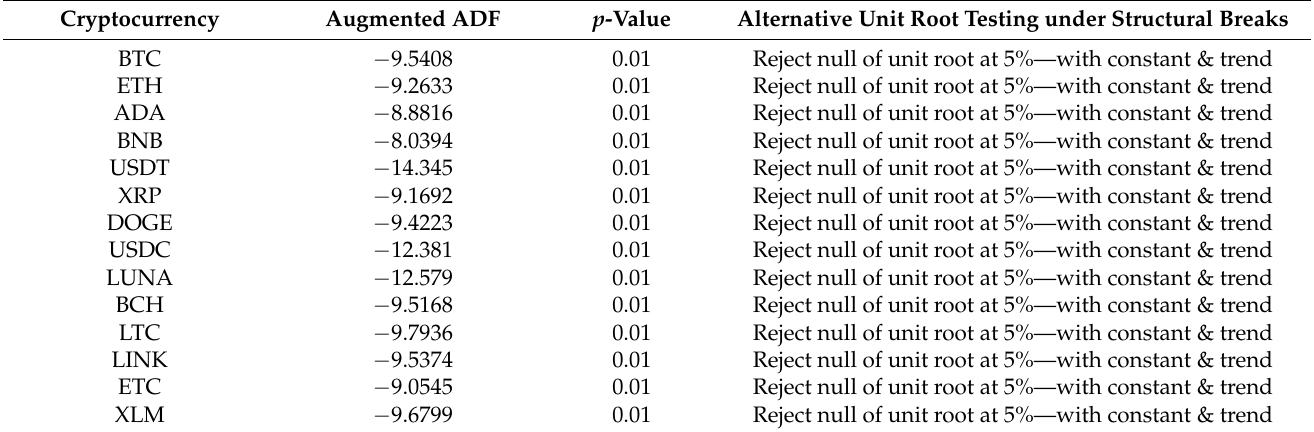
Figure 1. Graphical display by principal component analysis. Table 4. Augmented ADF and alternative unit root tests. Data range is from 1/1/2019 to 8/27/2021. Each variable is calculated as log(P t /P t − 1 ) and expressed as a percentage.